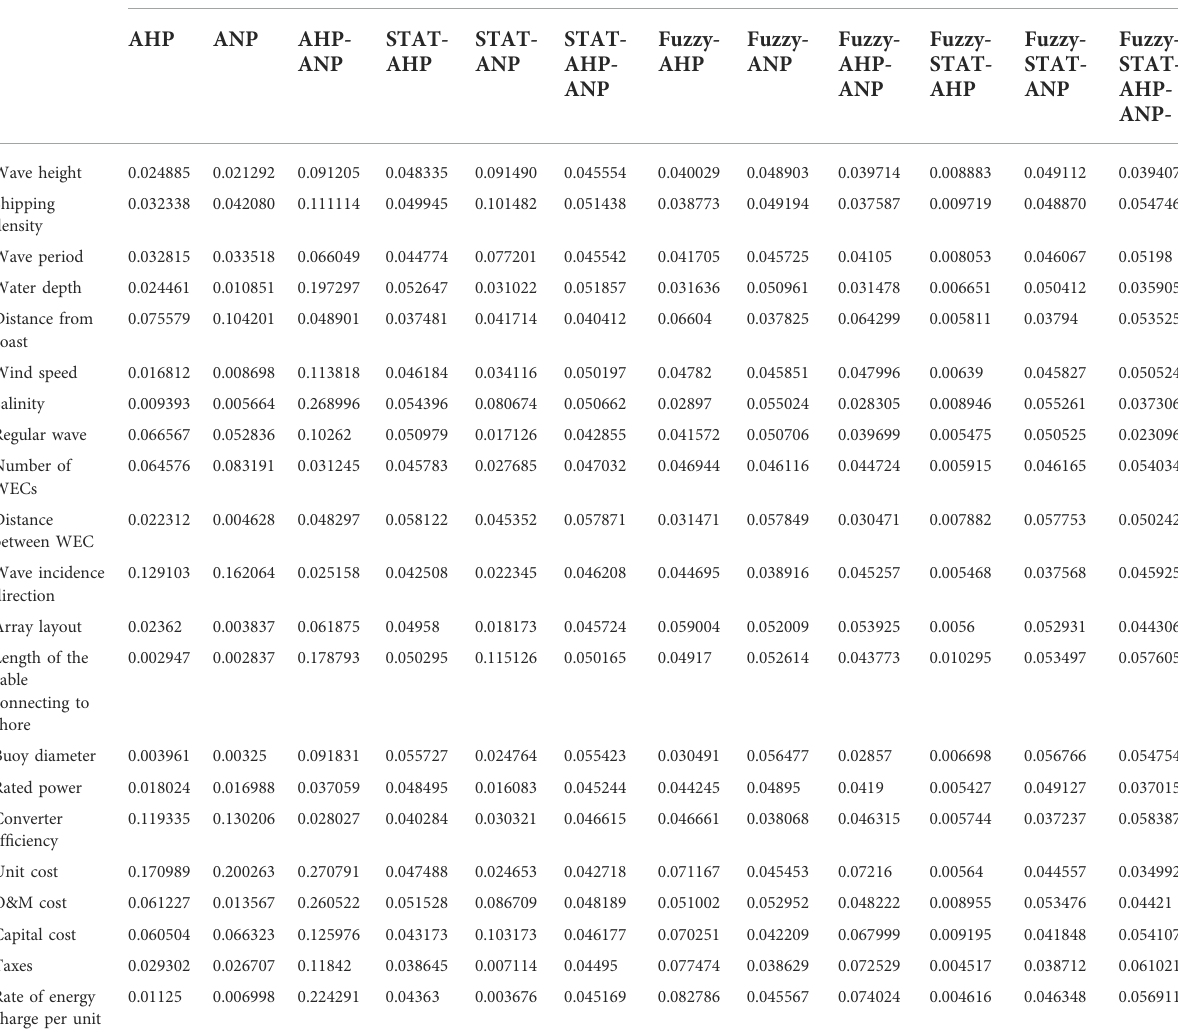
TABLE 4 Table showing the parameters as determined by various MCDM